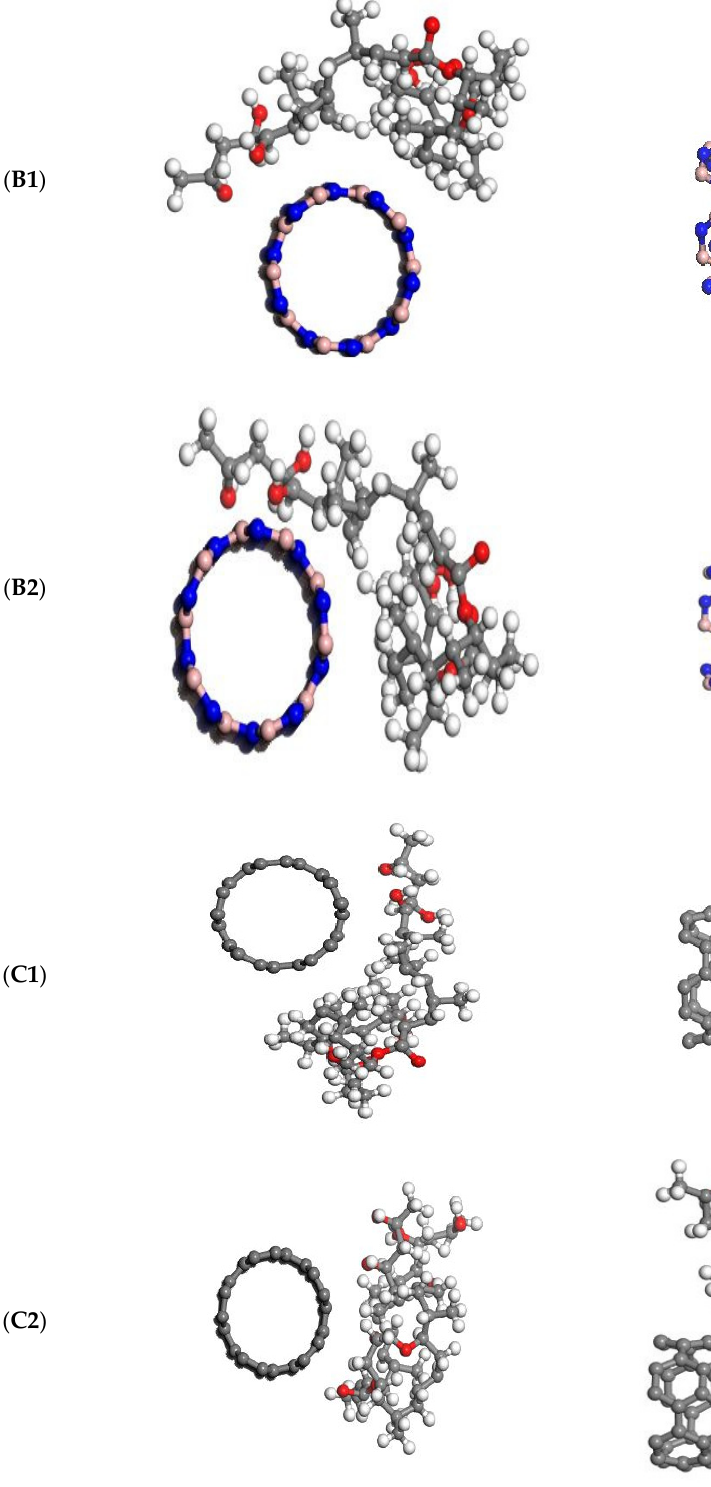
Figure 2. The top and side views of the optimized structures of the mycolactone on armchair BNNT (5,5) and armchair CNT (5,5). ( B1 )—Mycolactone on a center of BNNT’s surface, ( B2 )—Mycolactone on the far end of the BNNT’s surface, ( C1 )—Mycolactone on the center of the CNT’s surface, and ( C2 )—Mycolactone on the far end of the CNT’s surface.